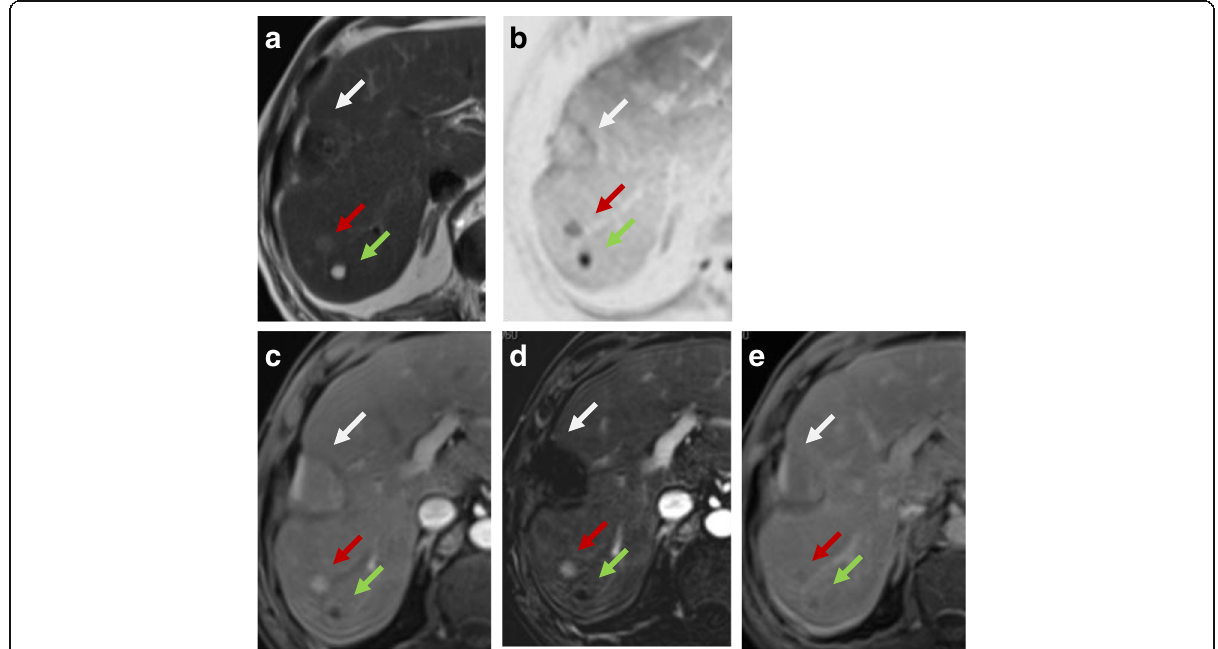
Fig. 5 Hepatic focal lesion after RFA. a T2-WI shows a well-defined treated subcapsular focal lesion (white arrow). Two other smaller lesions are seen posteriorly; one is of an intermediate signal (red arrow) and the other is of a high signal (green arrow). b Inverse of DWI shows no restriction of the treated lesion (white arrow), yet shows restriction of the other two lesions. ADC (not shown) shows T2 shine through of the posterior lesion (green arrow) with true restriction of the anterior lesion (red arrow). c Enhanced T1-WI in the arterial phase shows a high signal of the treated lesion that can be misinterpreted as an arterial hyperenhancing focal lesion. Note the enhancement of the anterior lesion and non-enhancement of the posterior small lesions. d Subtracted image shows no appreciable enhancement of the treated lesion and posterior lesion, yet shows definite enhancement of the red- arrowed lesion. e Delayed T1-WI shows washout of the red-arrowed lesion. Final diagnosis is LR-TR nonviable, new small HCC, and small hepatic cyst